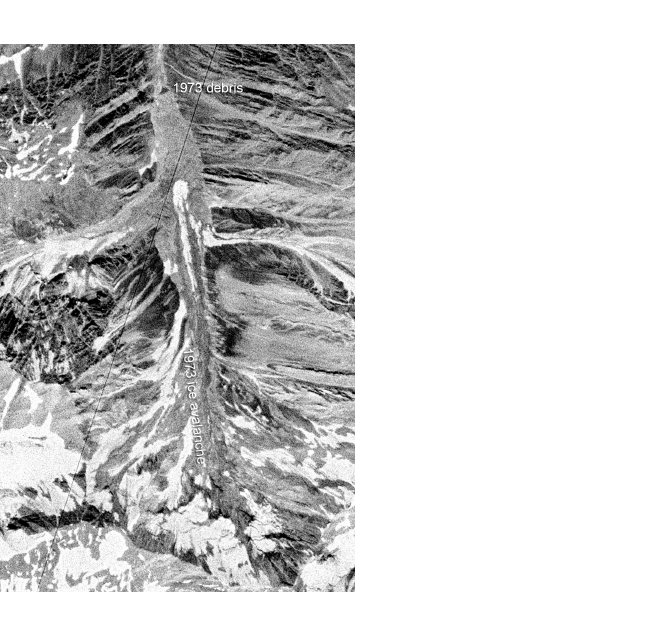
Figure A1. KH-9 image of the SK-73 rock-ice avalanche in the eastern Shuraki Kapali catchment (3 August 1973). Courtesy of the US Ge- ological survey.